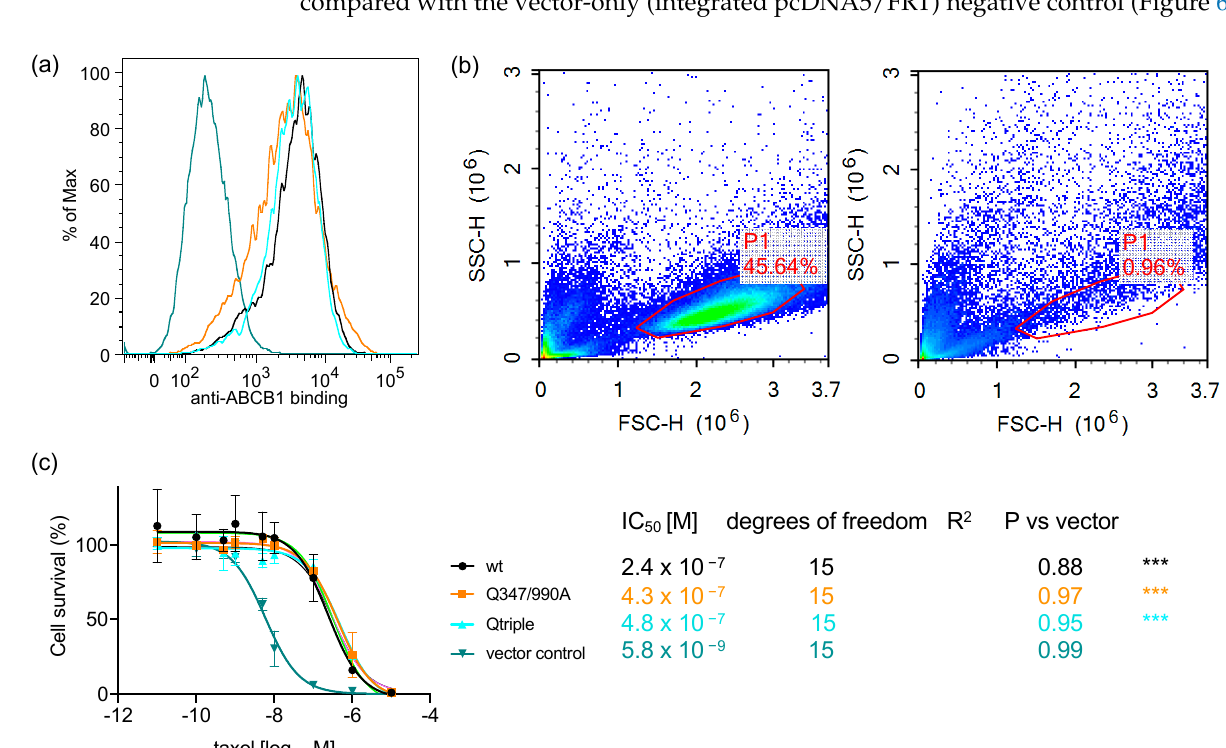
Figure 6. Stable expression of ABCB1-Q347/990A or ABCB1-Qtriple confers the same level of resistance to taxol as wild-type ABCB1. ( a ) Surface expression of ABCB1 (4E3 antibody binding) is similarly elevated for the two mutants (Q347/990A in orange and Qtriple in cyan) and the wild-type transporter (black) compared to the vector-only control (teal); ( b ) Flow cytometric exemplar dotplots in the presence and absence of taxol. Plots for the Flp-In ABCB1-Q347/990A cell line shows the forward scatter (FSC) and side scatter (SSC) heights in the absence (left hand plot) and the presence of 10 µ M taxol for 72 h (right hand plot). All cells of normal size and granularity in the well were counted in a NovoCyte flow cytometer and analysed in NovoExpress software. The P1 gate which defines the healthy cell population in the absence of taxol was copied to all other conditions. In the examples shown, there were 71,969 cells in the P1 gate in the absence of taxol and 943 cells in the P1 gate following exposure to 10 µ M taxol; ( c ) Non-linear regression analysis of cell survival on challenge with increasing concentration of taxol (colour code as above). Cell number in each well of the taxol dilution series was normalized to 100% for the P1 gate of the zero-taxol condition. The mean ± SEM was plotted with curve fitting by non-linear regression in GraphPad Prism version 8; sample number, n = 2 biological repeats. The biological repeats were averaged from duplicate technical repeats. *** p < 0.0001 compared to the vector-only cell line. The cell lines expressing the double and triple mutant ABCB1 are not significantly different to that expressing the wild-type transporter.